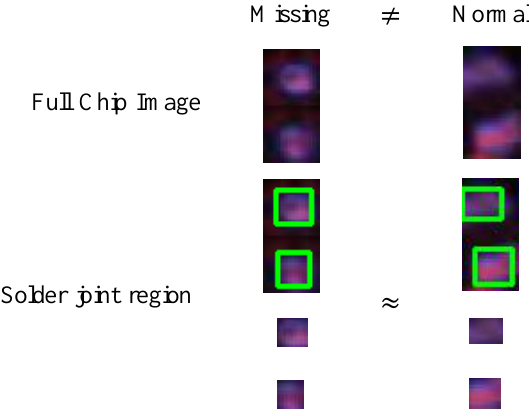
Figure 13. Failure case in defect classification using a dual-input CNN.